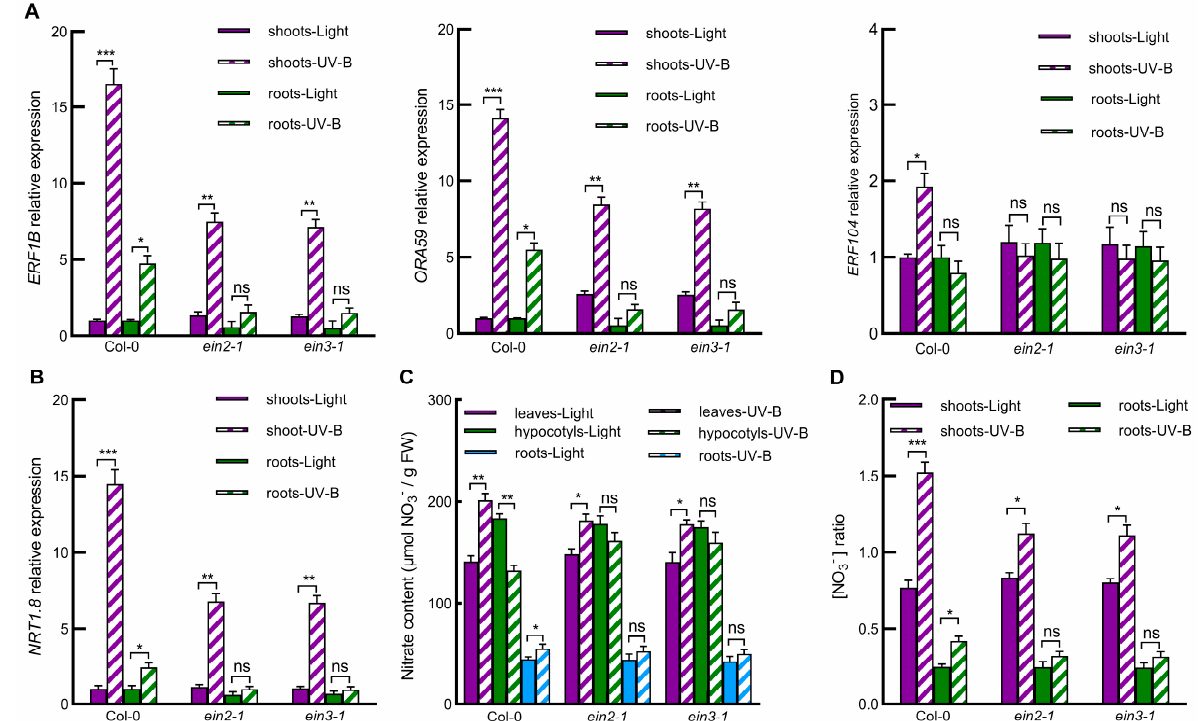
Figure 4. The ethylene signaling pathway was involved in UV-B-induced nitrate reallocation through regulating gene expression of the ERFs - NRT1.8 signaling module. ( A , B ) Expression of ERF1B , ORA59 , and ERF104 ( A ) or NRT1.8 ( B ) was determined by qPCR in shoots and roots of wild-type Col-0, ein2-1 , and ein3-1 plants exposed to light alone (Light) or with 0.5 W/m 2 UV-B (UV-B) for 3 h. Data are presented as values relative to that of wild-type Col-0 under light treatment after normalization to those of ACTIN2 . ( C , D ) Nitrate concentration was determined in leaves, hypocotyls and roots of wild-type Col-0, ein2-1 and ein3-1 plants exposed to light alone (Light) or with UV-B (UV-B) for 3 h ( C ), and then leaf/hypocotyl (L/H) and root/hypocotyl (R/H) nitrate ratios were calculated ( D ). Values are means ± SE ( n = 3). Values with asterisks indicate significant differences between light and UV-B treatments (* p < 0.05; ** p < 0.01; *** p < 0.005; ns: no significant difference).